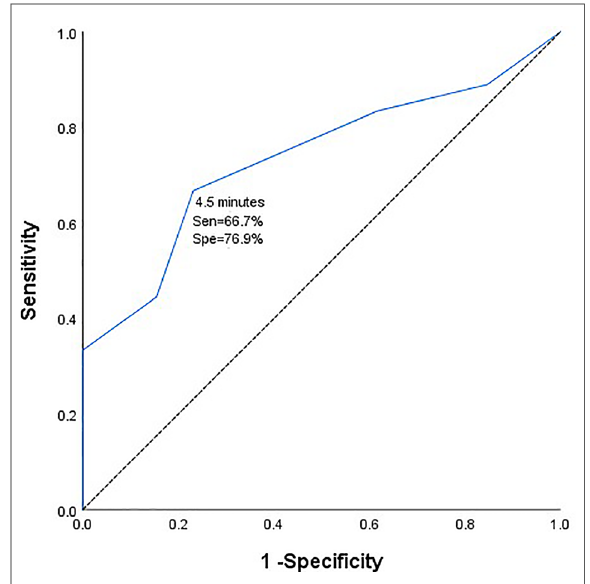
FIGURE 1 Receiver operating characteristic curve of duration of intraoperative temporary clipping and electrophysiological monitoring and warning.